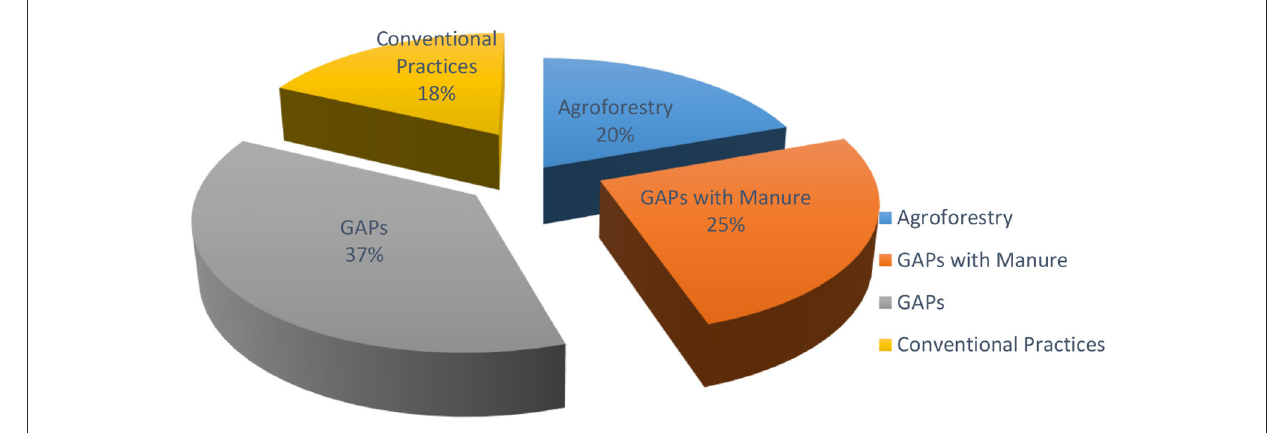
49% of their parcels on a leasehold agreement. Figure 5 also shows that only 4% of the sampled farmers had their land registered with the land registry. This implies that only a few out of the sampled smallholder farmers had de jure tenure security while the majority had insecure tenure, which can lead to eviction from their farmland and regular harassment by the land grabbers. The result is closely in line with the findings of Birner and Okumo (2012) and Shittu et al. (2018) who found that only three percent of the land in Nigeria are formally